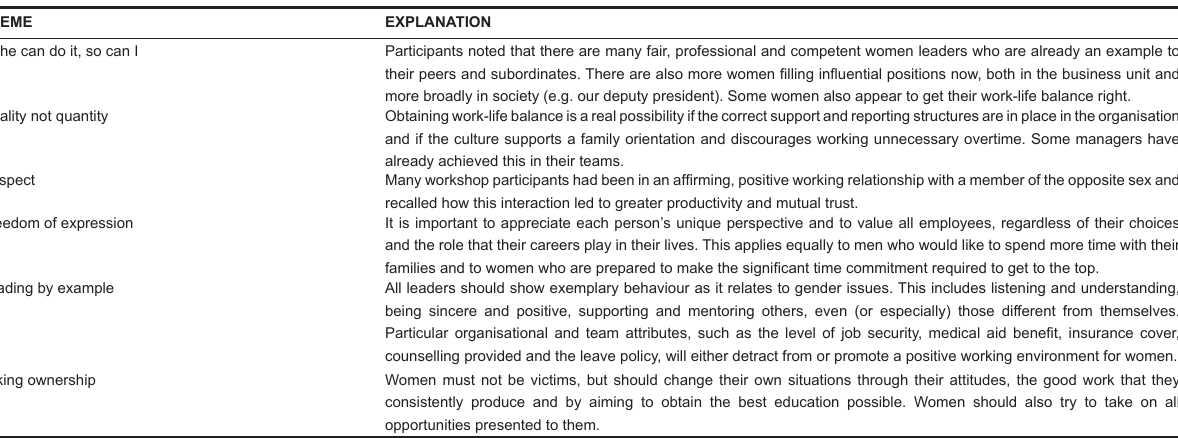
TABLE 2 Summary of themes emerging from the Discovery Stage